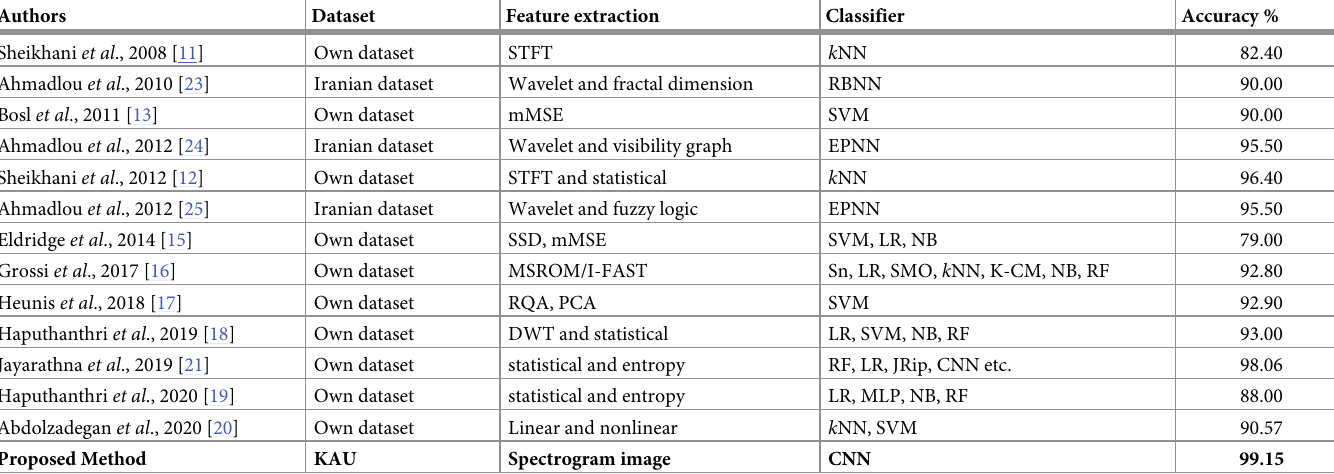
Table 4. Comparison with proposed and existing methods using different